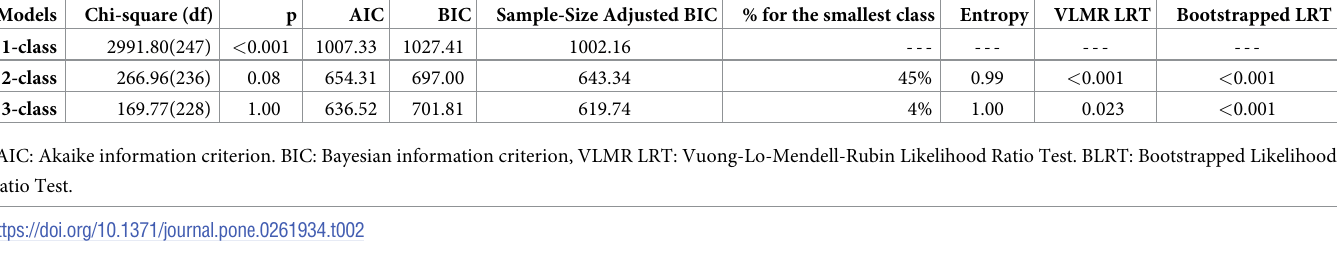
Table 2. Model fit criteria comparing 1-class, 2-class, 3-class latent class analysis model.